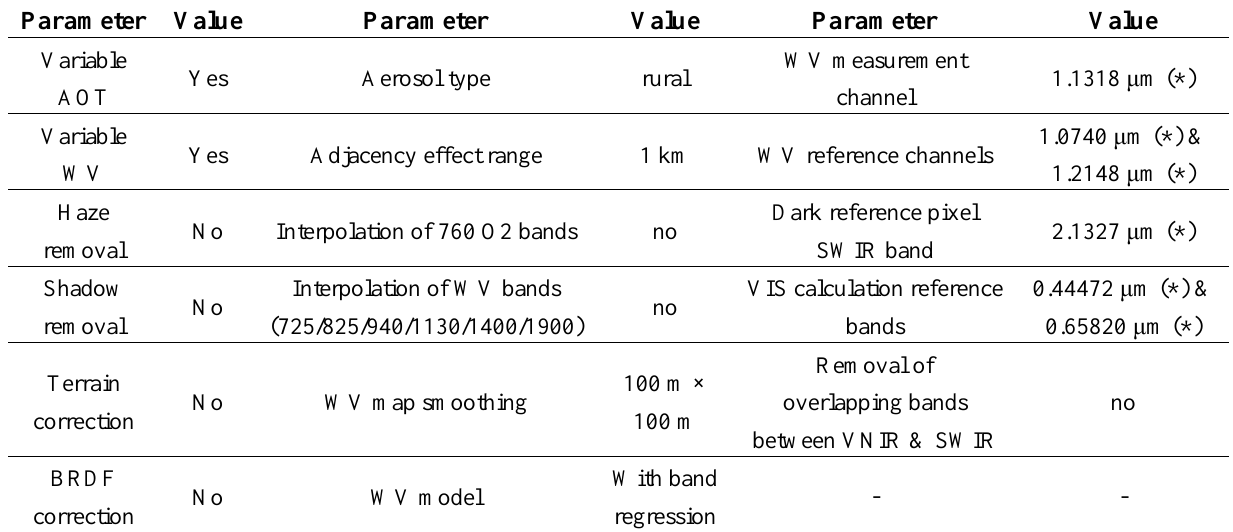
bands can be different in case of the spectral shift